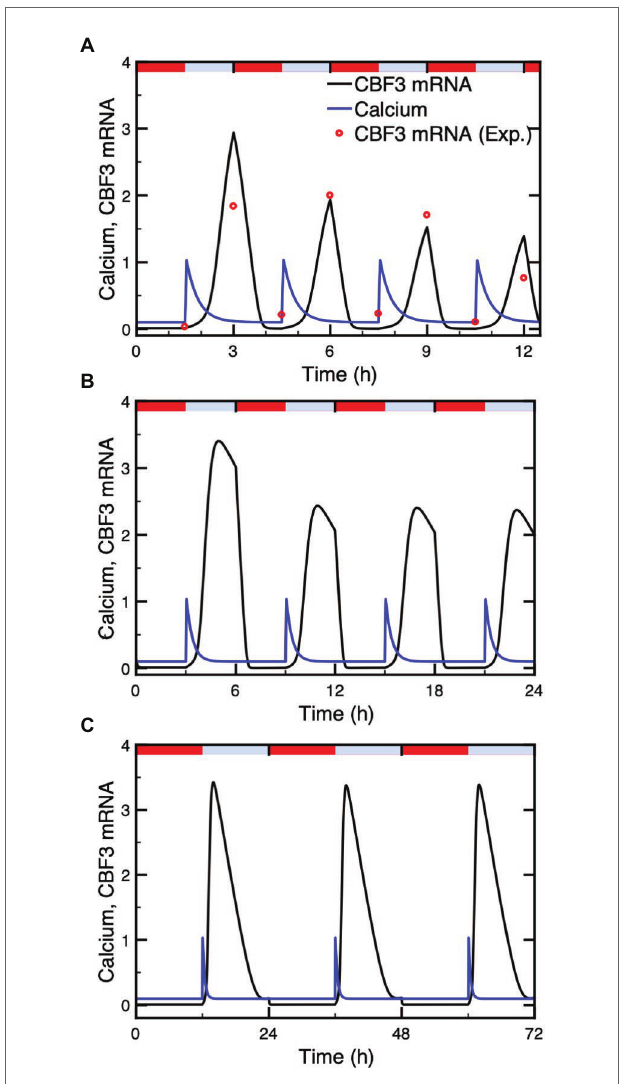
FIGURE 6 | Dynamics of the cold response pathway subjected to repetitive cold stresses. Shown is the CBF3 mRNA (black curve) under identical Ca 2+ pulses (blue curve) administered at intervals of 3 h (A) , 6 h (B) , and 24 h (C) . The Ca 2+ pulses in the three panels have the same duration. Identical Ca 2+ pulses are assumed to be elicited at the beginning of each cold phase, which is followed by a warm phase of similar duration. The duration of these phases is equal to 90 min (A) , 3 h (B) , or 12 h (C) . Repetitive cold stimuli are assumed to produce identical Ca 2+ spikes. The experimental data (red points) are redrawn from Figure 2A in Zarka et al. (2003). The red bars and blue bars on top of each panel represent warm (20 ° C) and cold (4 ° C) phases, respectively. Parameter values are listed in Supplementary Table 2 . The results are obtained by numerical integration of eqs. (1) and (4)–(17), and by means of eq. (3) for the determination of CaM (see Supplementary Material Sections 1 and 2), using the XPP program. The degradation rate of CBF3 mRNA is 0.55 and 5.5 in cold and warm phases,